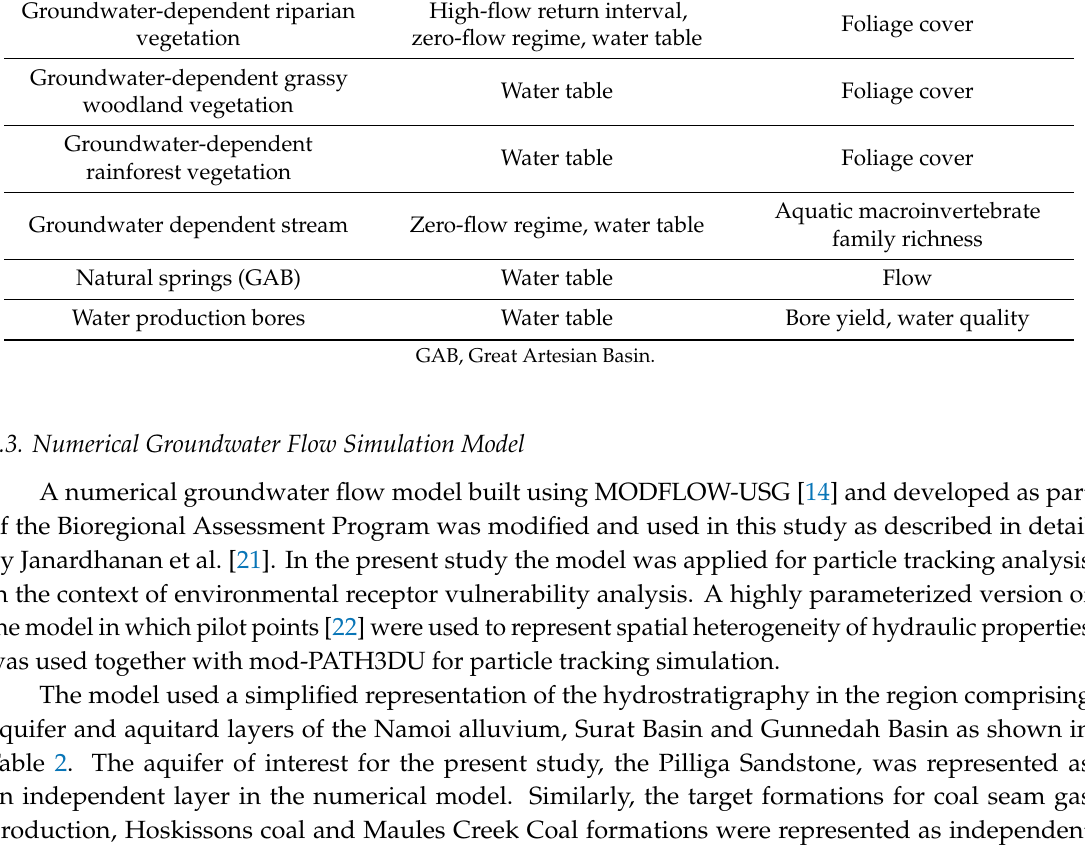
Table 1. Receptors, hydrological response variables and potential impact metrics (adapted from [20]). Receptor High-flow return interval, water Foliage cover table High-flow return interval, Foliage cover vegetation zero-flow regime, water table Water table Foliage cover woodland vegetation Water table Foliage cover rainforest vegetation Aquatic macroinvertebrate Zero-flow regime, water table family richness Water table Flow Water production bores Water table Bore yield, water quality GAB, Great Artesian